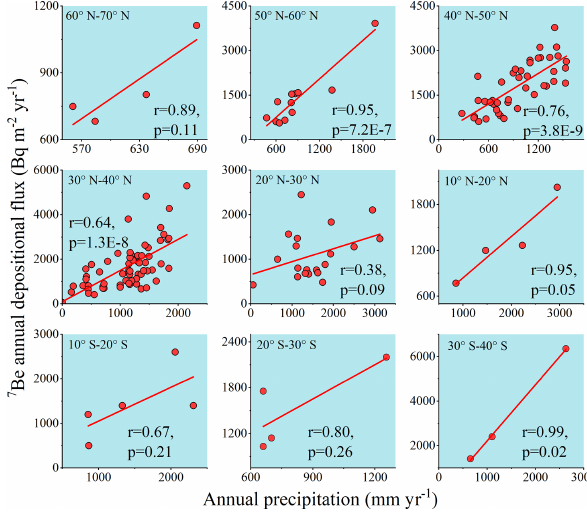
Figure 7. Annual depositional fluxes of 7 Be are plotted against an- nual precipitation for 10 ◦ latitudinal